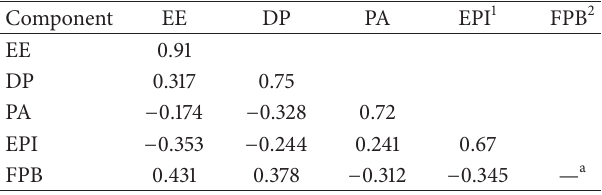
Table 5: Component correlation